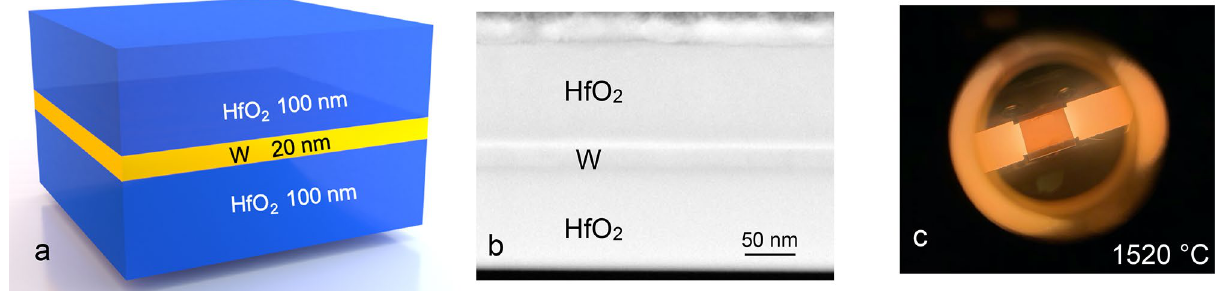
Figure 1. ( a ) Schematic of the 3-layer-system used in the annealing experiment ( b ) scanning transmission electron microscope (STEM) image of an as-prepared 3-layer-system; prior to focused ion beam (FIB)